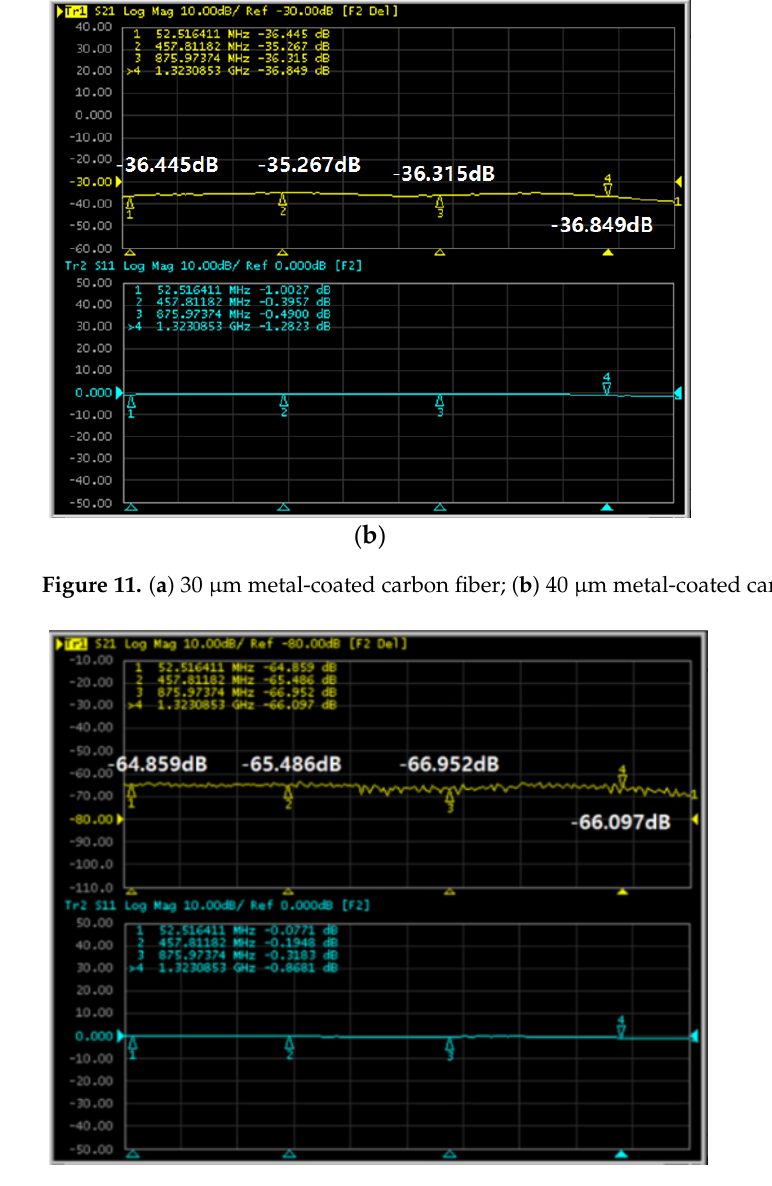
Figure 12. Electromagnetic shielding performance of the metal coating carbon fiber 100 μm.